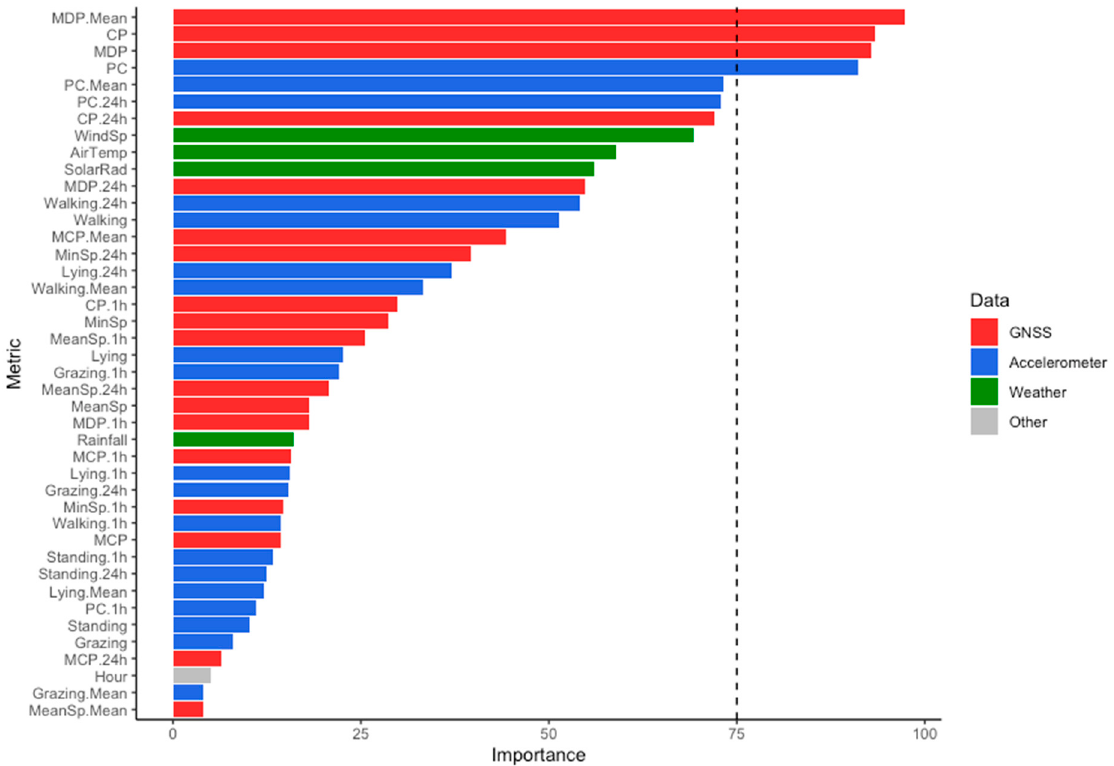
Figure 1. Feature importance for the integrated dataset determined by receiver operating characteristics (ROC) curve analysis. Data types are: GNSS-derived (red); accelerometer-derived (blue); weather (green) and other (grey). Only those metrics with an importance “score” above the chosen threshold (dashed line) were used in the ML. Refer to Table 1 for definitions.